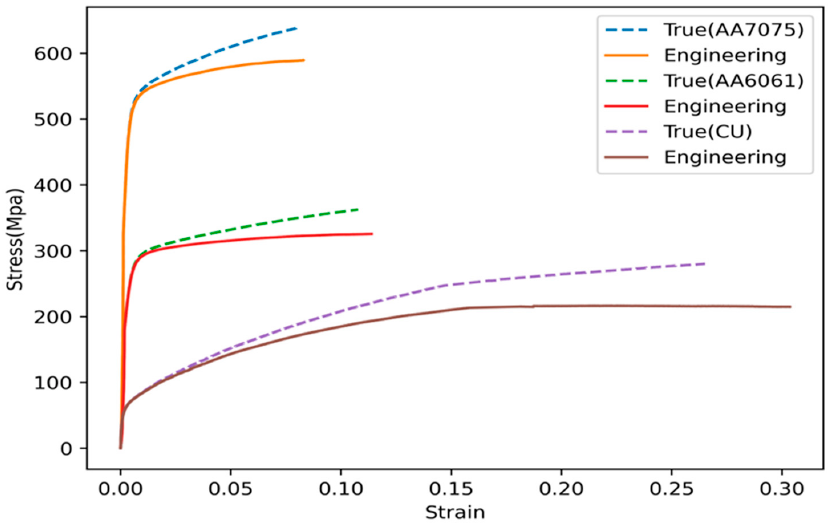
Figure 5. True and engineering stress-strain curves of AA7075-T6, AA6061-T6 and Cu materials.